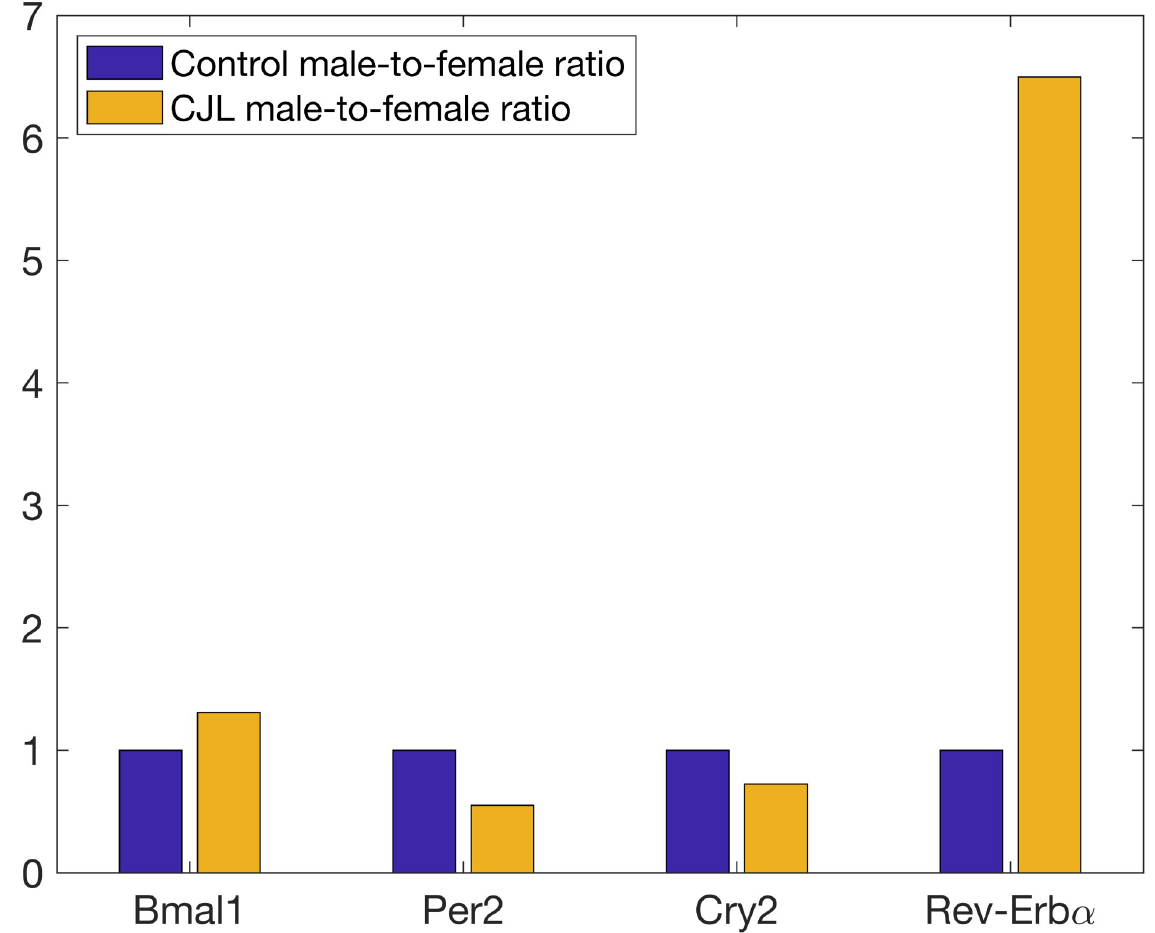
Fig 2. Male-to-female relative abundance of mRNAs for controls and shifters, normalized by control male-to-female